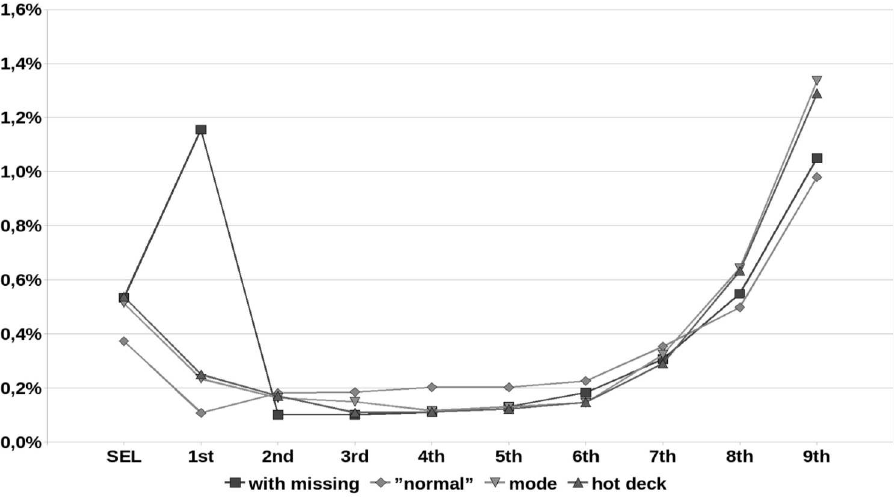
Figure 4. Average percentage of days classified as infertile during the monthly cycle for each of the compared DBN models for the selected approaches to handling missing data. The x-axis (horizontal) in the figure represents a particular model created for each woman (nine DBNs of temporal orders ranging from 1 to 9 and a model with a structure that can change after each cycle was proposed, called “ SEL ” model)